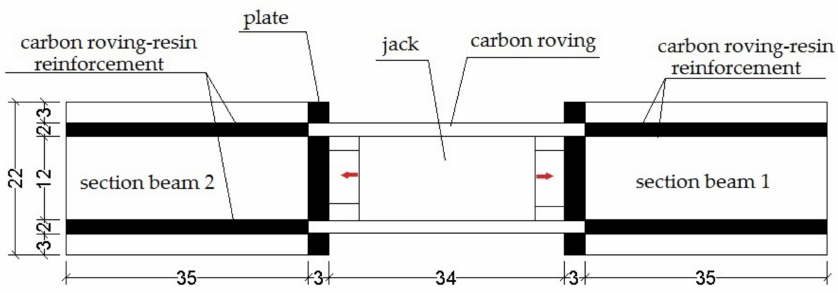
Figure 9. Scheme of the wood-reinforcement adhesion test.